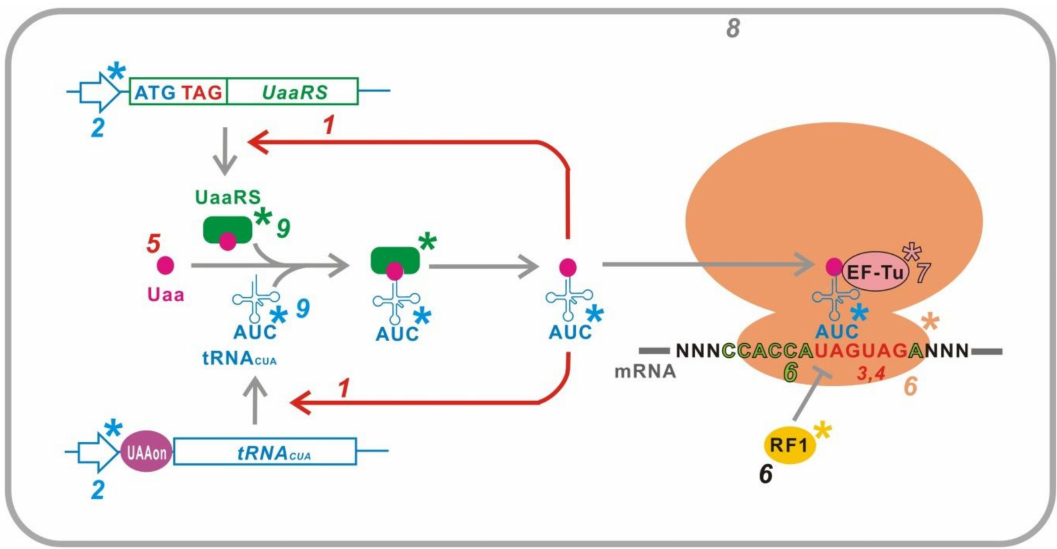
Figure 5. G3. Various relevant factors for switching are optimized in G3, such as (1) inducible UaaRS/tRNA CUA , (2) optimization of UaaRS/tRNA CUA expression level, (3) multiplexed UAG insertion in a target gene, ( 4 ) location of the UAG insertion, (5) Uaa-residue converting to a standard amino acid residue, ( 6 ) suppression of peptide release factor, ( 7 ) Uaa-permissive elongation factor, ( 8 ) host selection, and (9) improved UaaRS/tRNA CUA . Asterisk indicates a mutant optimized for switching use. UAAon, a transcriptional ON-switch controlled by